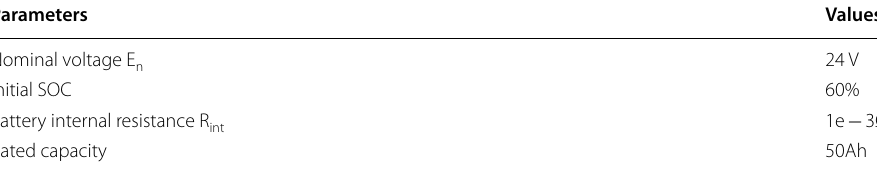
Table 3 Battery parameters